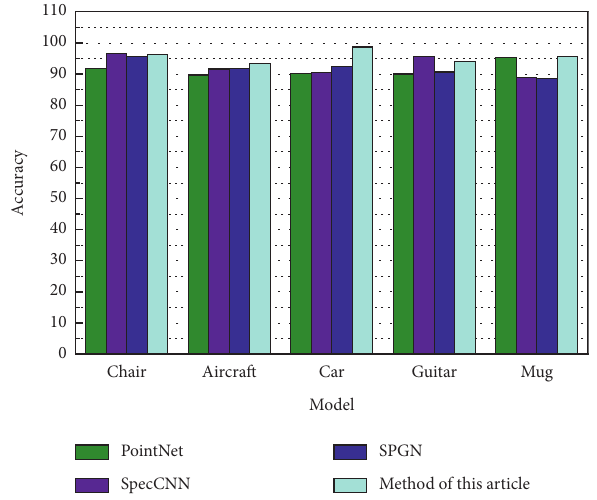
Figure 7: Comparison results of segmentation methods for IoU